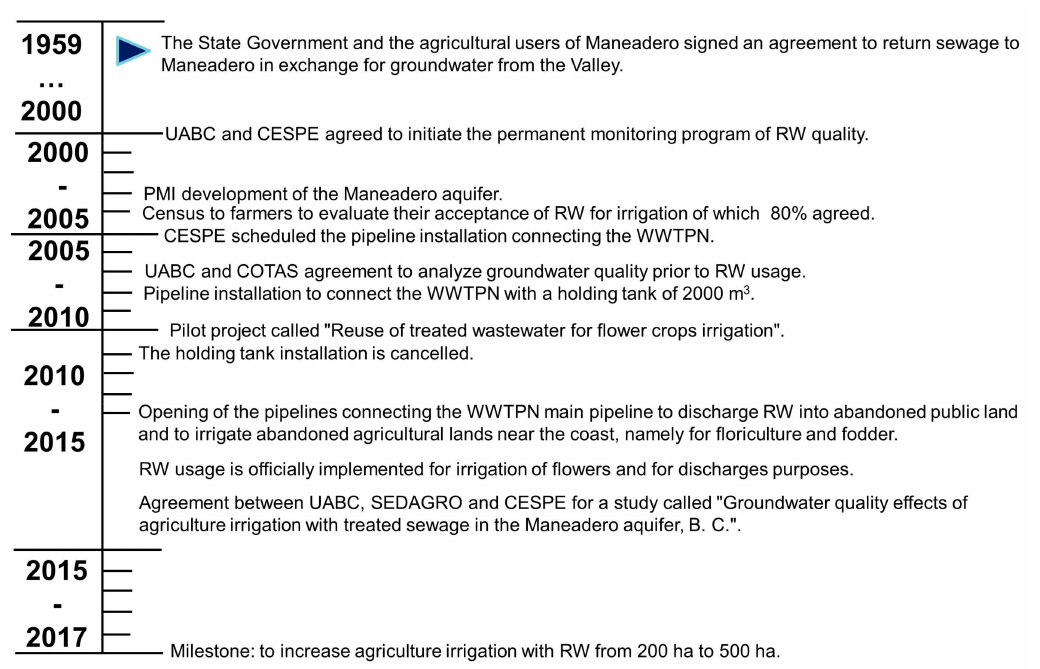
Figure 4. Relevant events leading the use of RW in the Maneadero